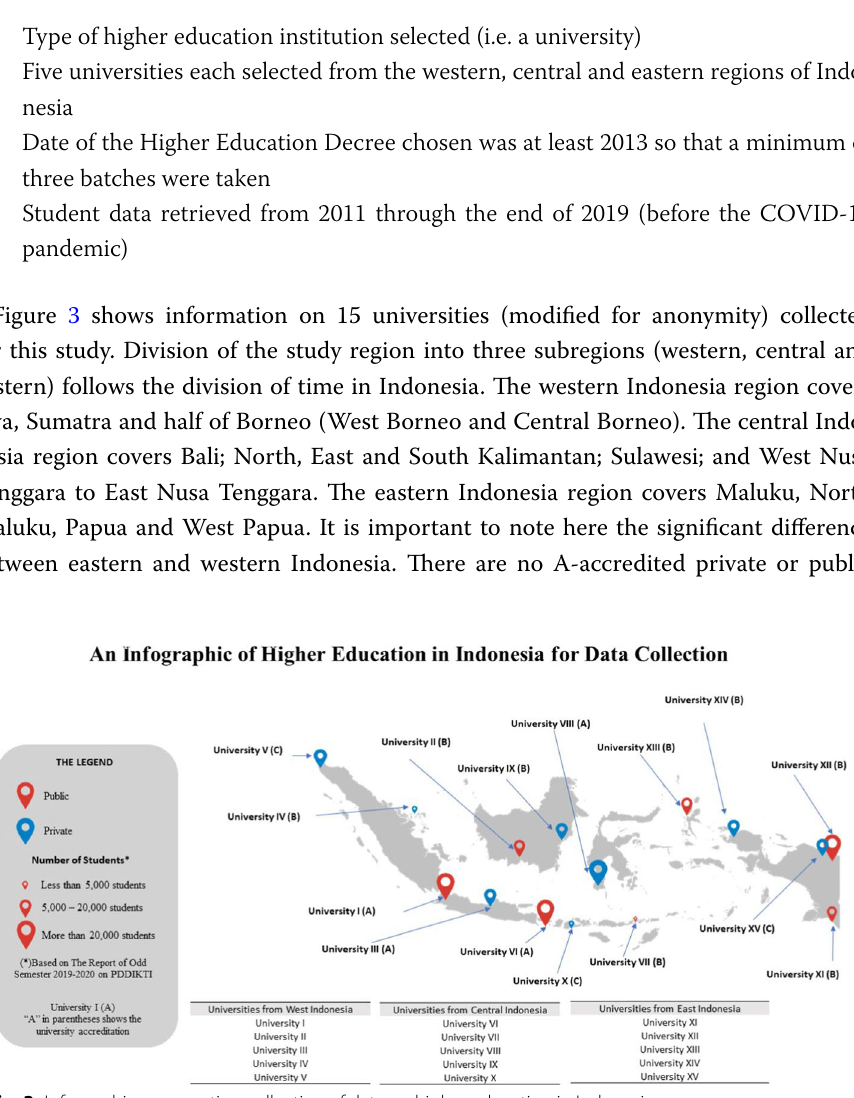
Fig. 3 Infographic representing collection of data on higher education in